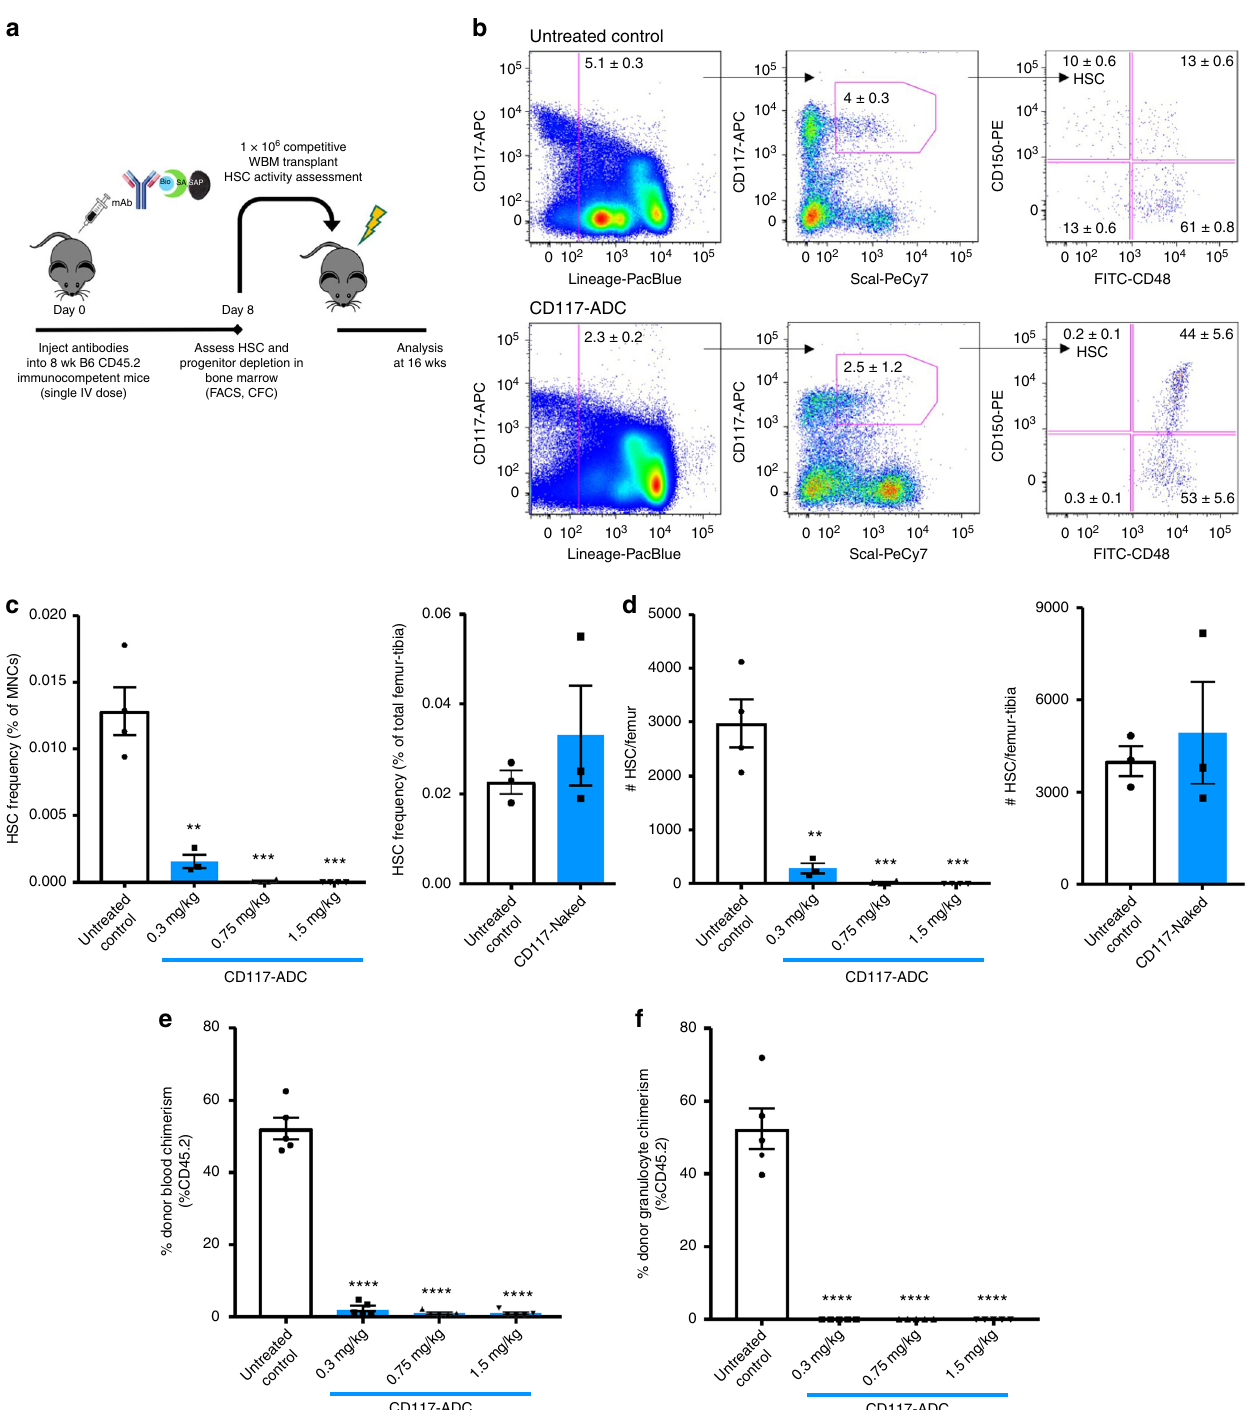
Fig. 1 One-time, intravenous treatment with CD117-ADC potently depletes hematopoietic stem cells (HSCs). a Experimental outline for assessing the ability of antibody-drug-conjugates to deplete HSCs in immunocompetent, wild-type C57BL/6 mice. HSCs and progenitors were assessed through fl ow cytometric (FACS) phenotypic analysis and colony-forming cell-forming assays, and in vivo reconstitution potential was assessed by competitive transplantation assays. b Representative FACS plots of bone marrow from untreated control and CD117-ADC-treated animals (2B8 clone bound to saporin toxin). c , d Dose-dependent phenotypic depletion of HSCs (Lin − cKit + Sca1 + CD150 + CD48 − ) by CD117-ADC and lack thereof by naked CD117 mAb as assessed 8 days after IV administration, displaying decreased HSC frequency ( c ) and total HSC number ( d ). Non-treated mice served as controls. e , f In vivo depletion of HSCs af fi rmed by lack of long-term reconstitution activity of treated WBM as assessed by donor total blood chimerism ( e ) and donor granulocyte chimerism ( f ) in competitive transplantation assays. Statistics calculated using unpaired t test. Data represent mean ± SEM. ( n = 3 – 5 mice/ group, assayed individually); all data points signi fi cant as indicated vs. untreated control (** P < 0.01, *** P < 0.001, **** P < 0.0001)